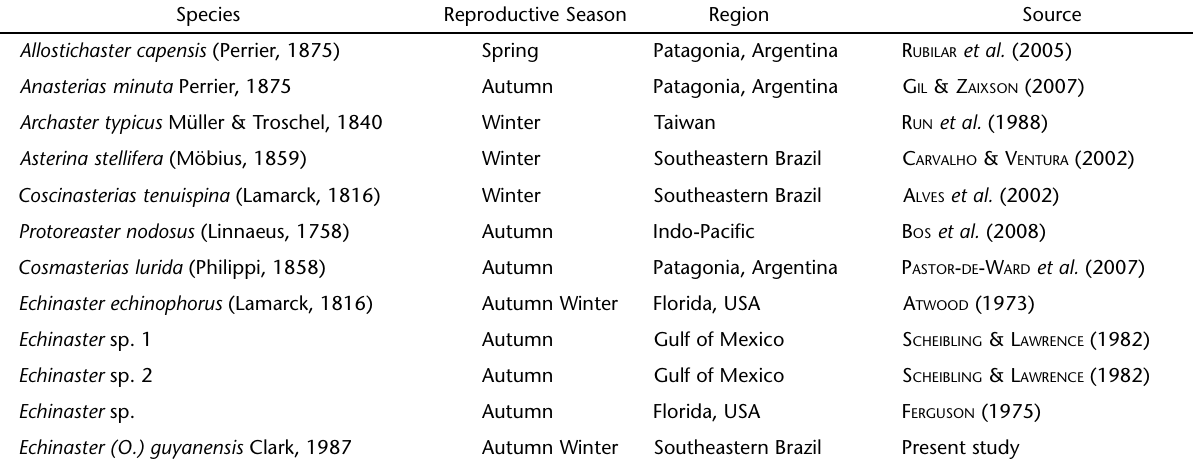
Table II. Reproductive seasons of some representative